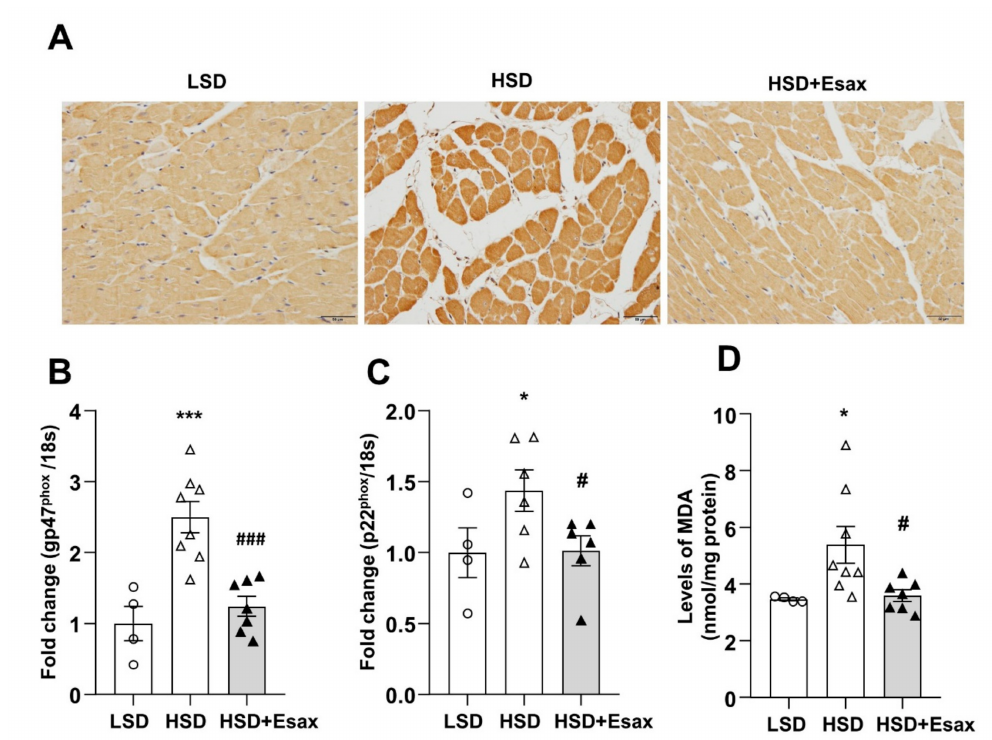
Figure 5. Esaxerenone treatment suppresses oxidative stress in HSD-fed DSS rats. ( A ) Immuno- histochemistry of 4-hydroxynonenal (HNE), magnification 200 × , scale bar: 50 µ m. The mRNA expression of oxidative stress markers: ( B ) gp47 phox and ( C ) p22 phox . ( D ) LV tissue content of mal- ondialdehyde (MDA). These oxidative stress markers were up-regulated in the HSD-fed DSS rats but down-regulated in those receiving the esaxerenone treatment. * p < 0.05, *** p < 0.001 vs. LSD; # p < 0.05, ### p < 0.001 vs.